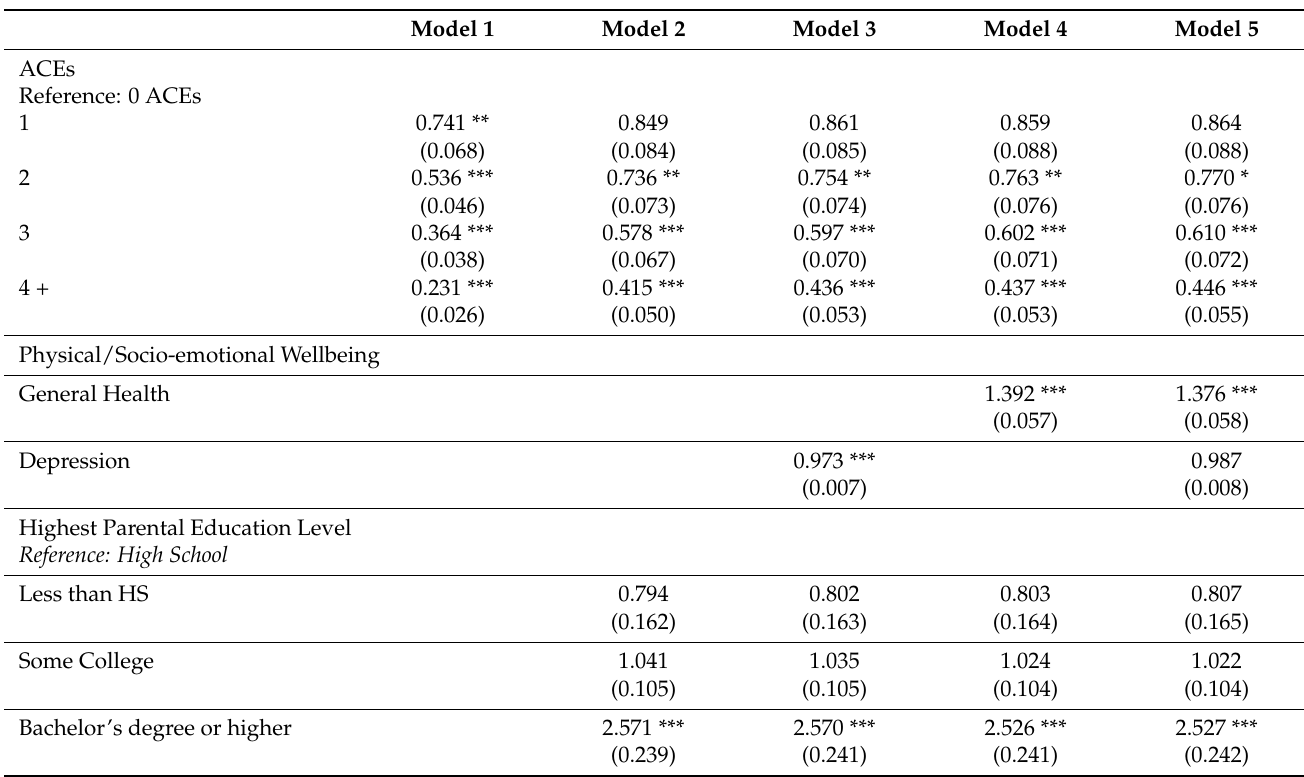
Table 3. Logistic regression (odds ratio) results of timely BA/BS attainment by ACEs (0, 1, 2, 3,